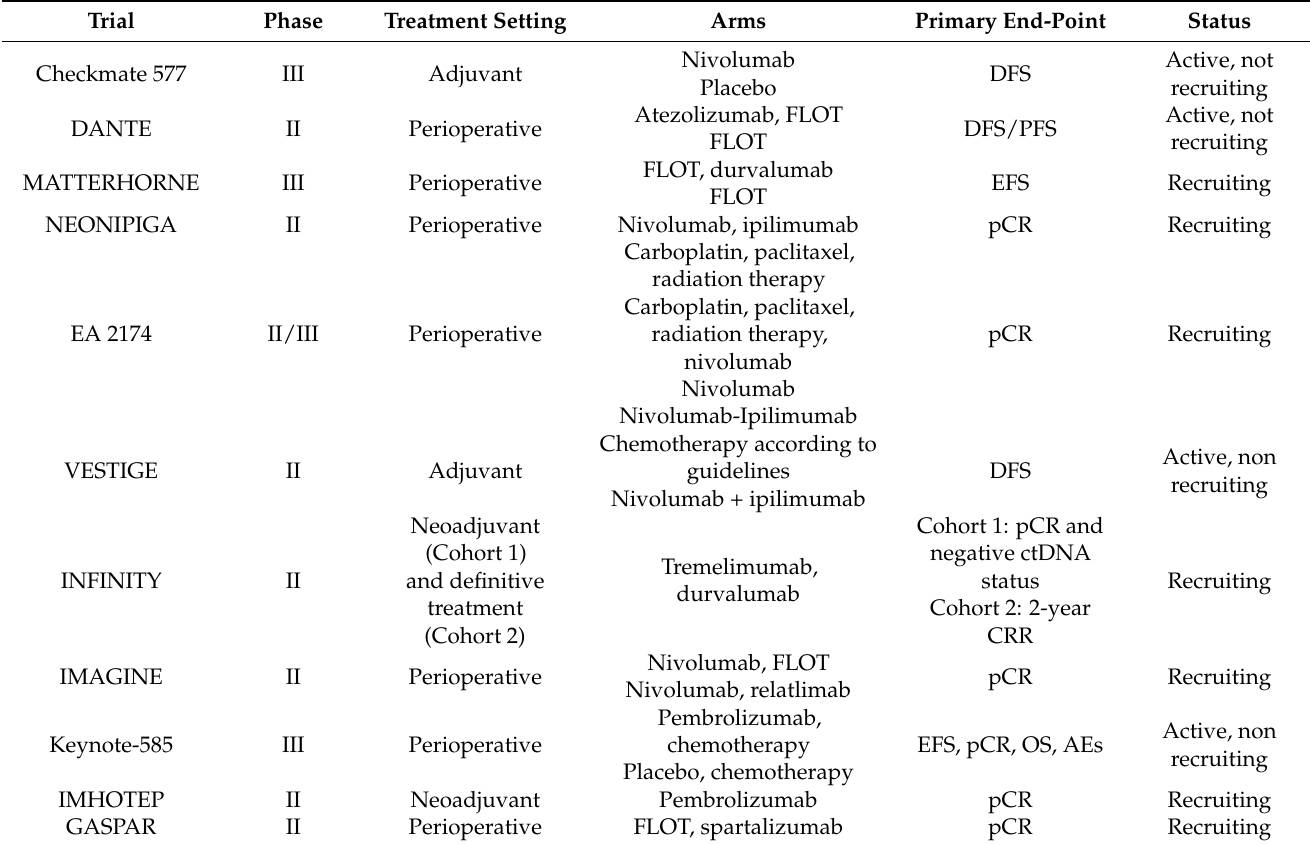
Table 2. Summary of the main trials with ICI in resectable G/GEJ